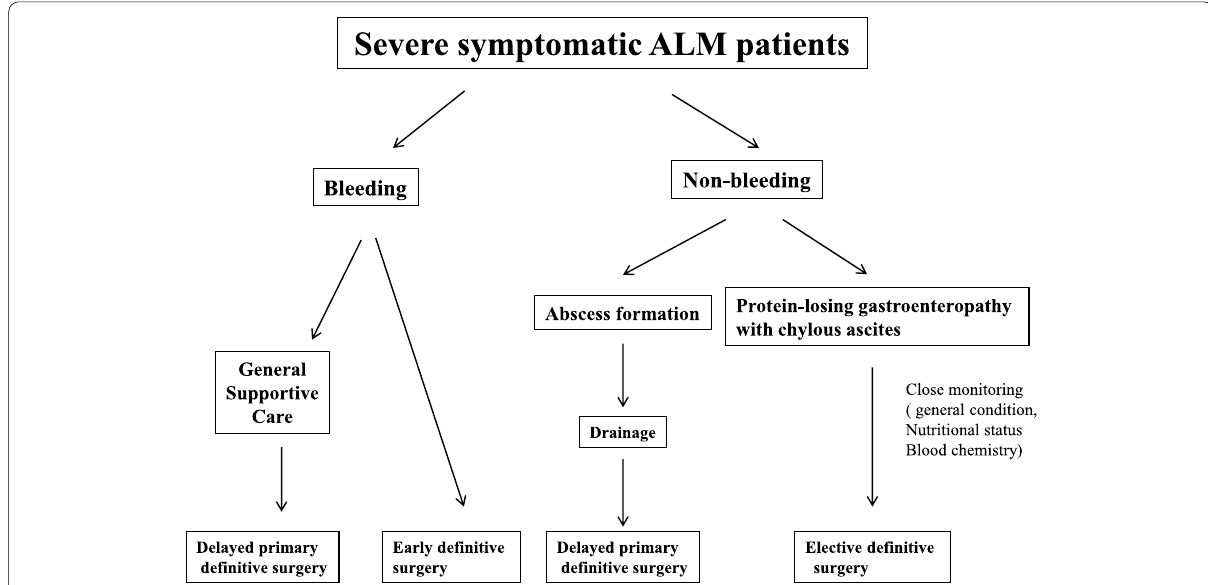
Fig. 2 Algorithm for the management of a symptomatic ALM patient at our institute. Severe symptomatic ALM patients who had bleeding underwent emergency resection, and those with non-bleeding complications such as abscess formation and PLGE with chylous ascites were scheduled for delayed primary surgery. Based on these findings, we developed an algorithm for the management of symptomatic ALM patients at our